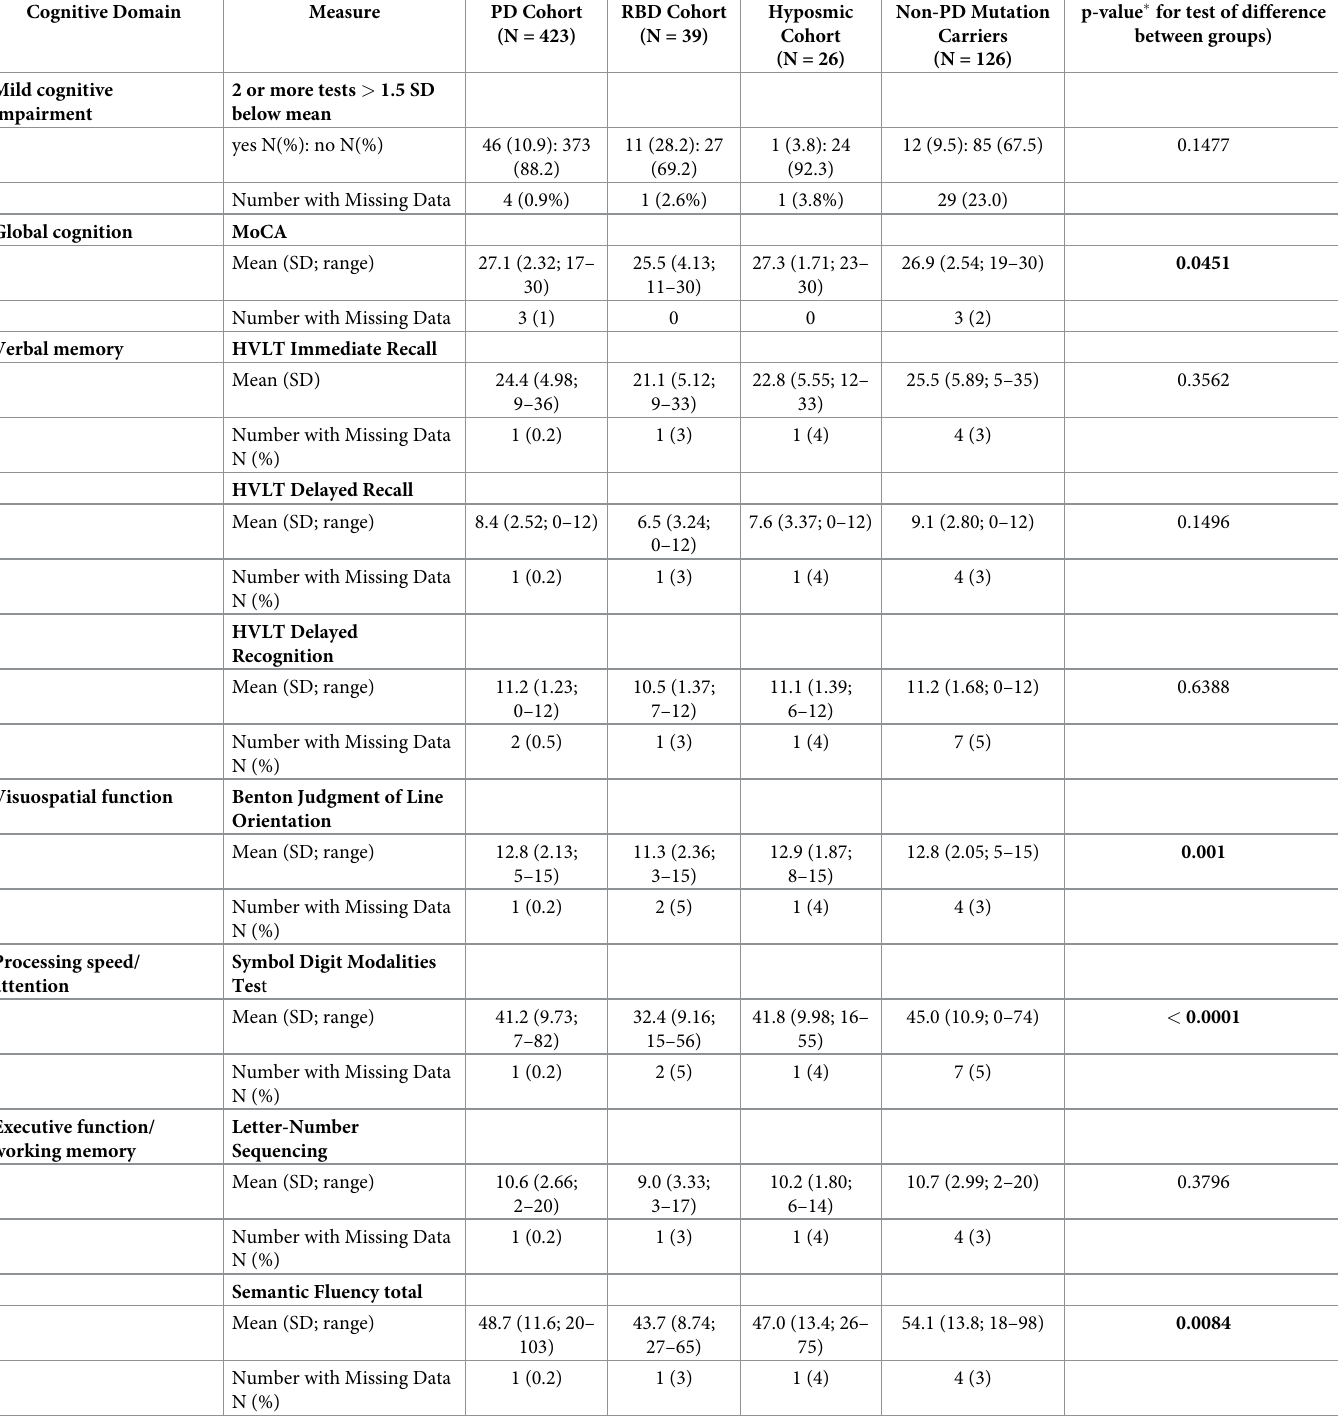
Table 2. Cognitive performance in the PD, RBD, hyposmic, and NPD-GC arms. Cognitive